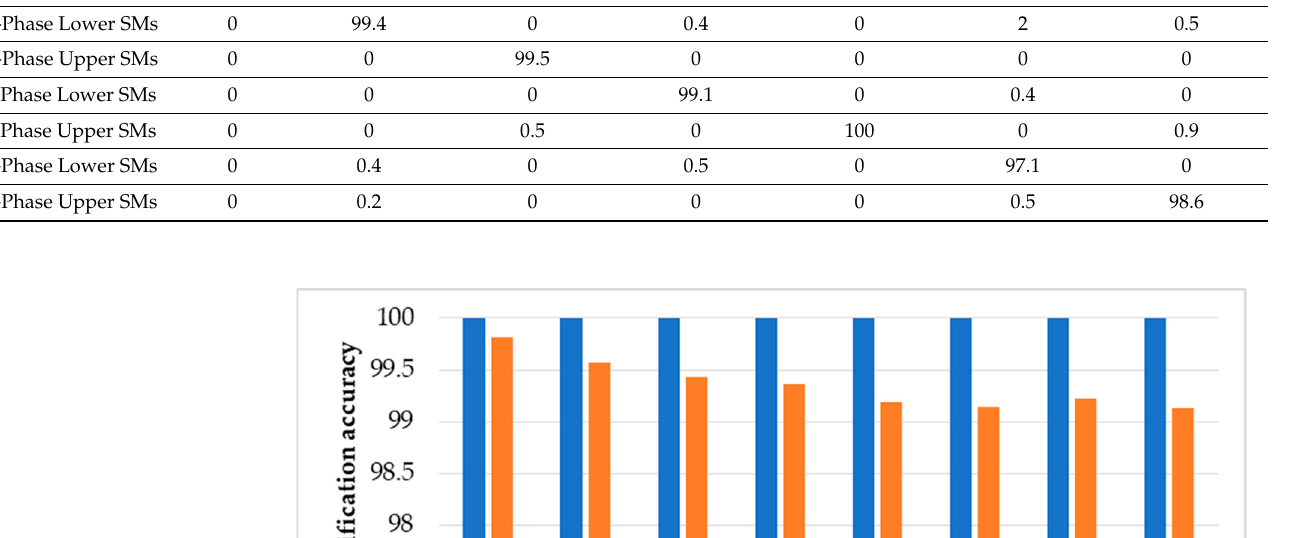
Figure 8. Classification results of training and testing data using MLR without data normalisation.